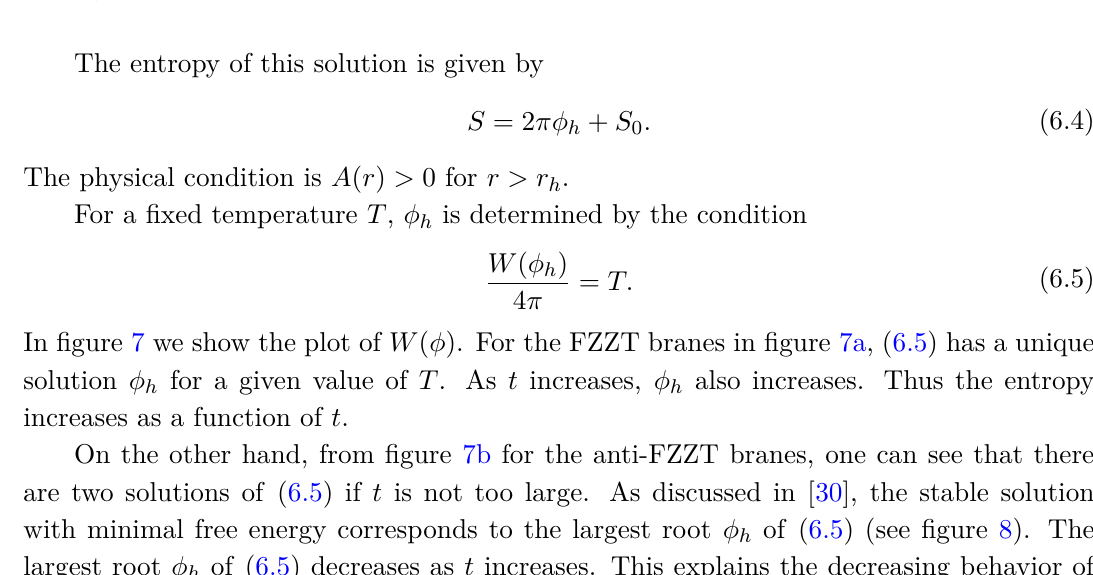
Figure 8 . Stability of black hole solutions in the anti-FZZT brane setup. The largest root φ h of (6.5) corresponds to the stable solution. The solution no longer exists for t > t c